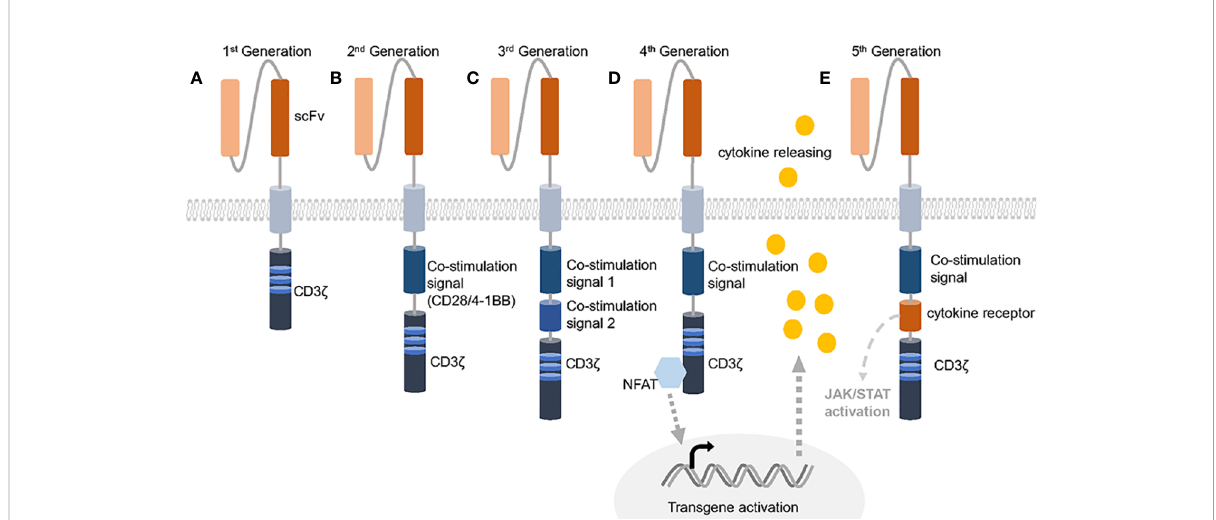
FIGURE 1 Five generations of CARs. (A) The 1st generation of CAR only contains the extracellular scFv and intracellular CD3 z activation domine, which could not trigger enough active response. (B) 2 nd generation of CAR has an additional co-stimulation domain based on 1st generation and obtained success against leukemia. (C) 3rd generation of CAR increases the number of co-stimulation domain and evoke stronger stimulation after antigen binding. (D, E) 4 th generation of CAR is usually referred to TRUCKs that contains one more cytokine inducer compared with 2 nd CAR to promote cytokine-mediated killing. 5 th CAR can both activate the cytokine receptor dependent JAK/STAT signal and perform the normal function of a 2 nd